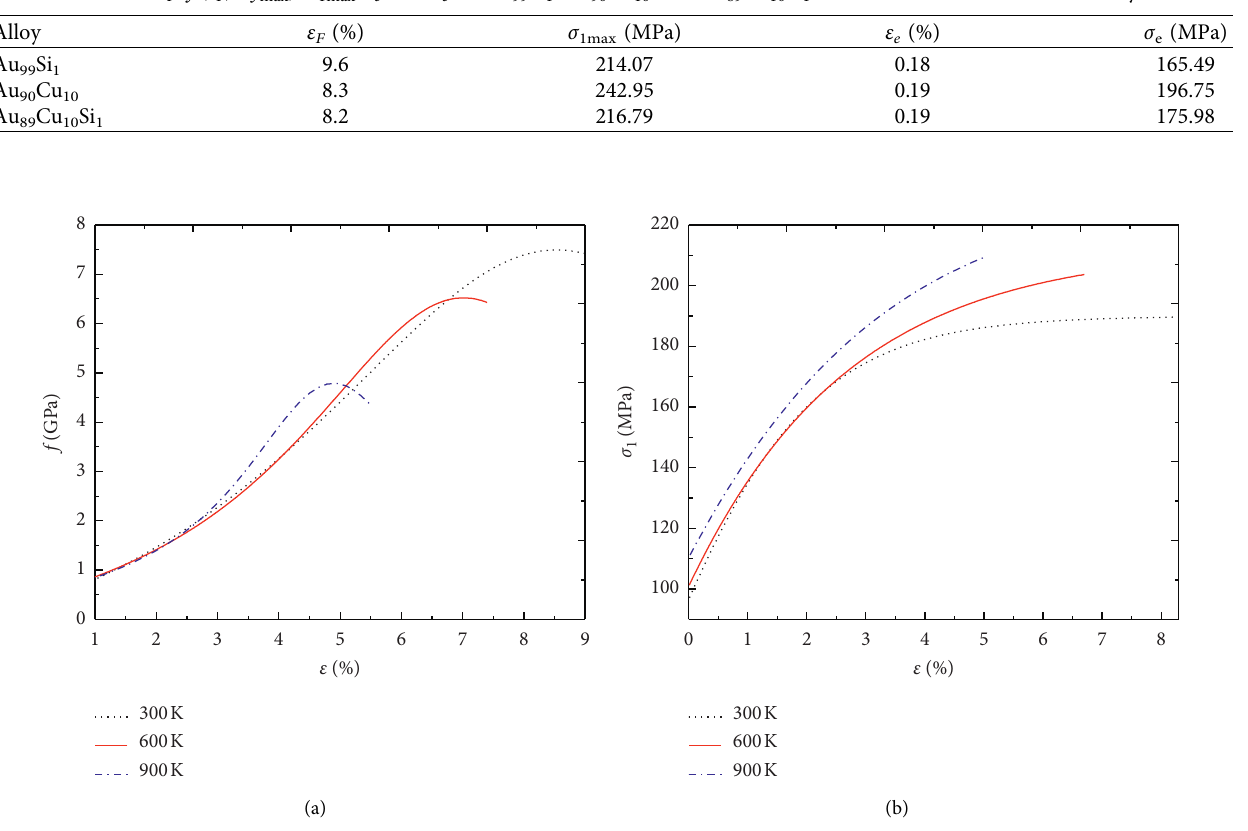
P � 0 and T � 300K calculated by the SMM.